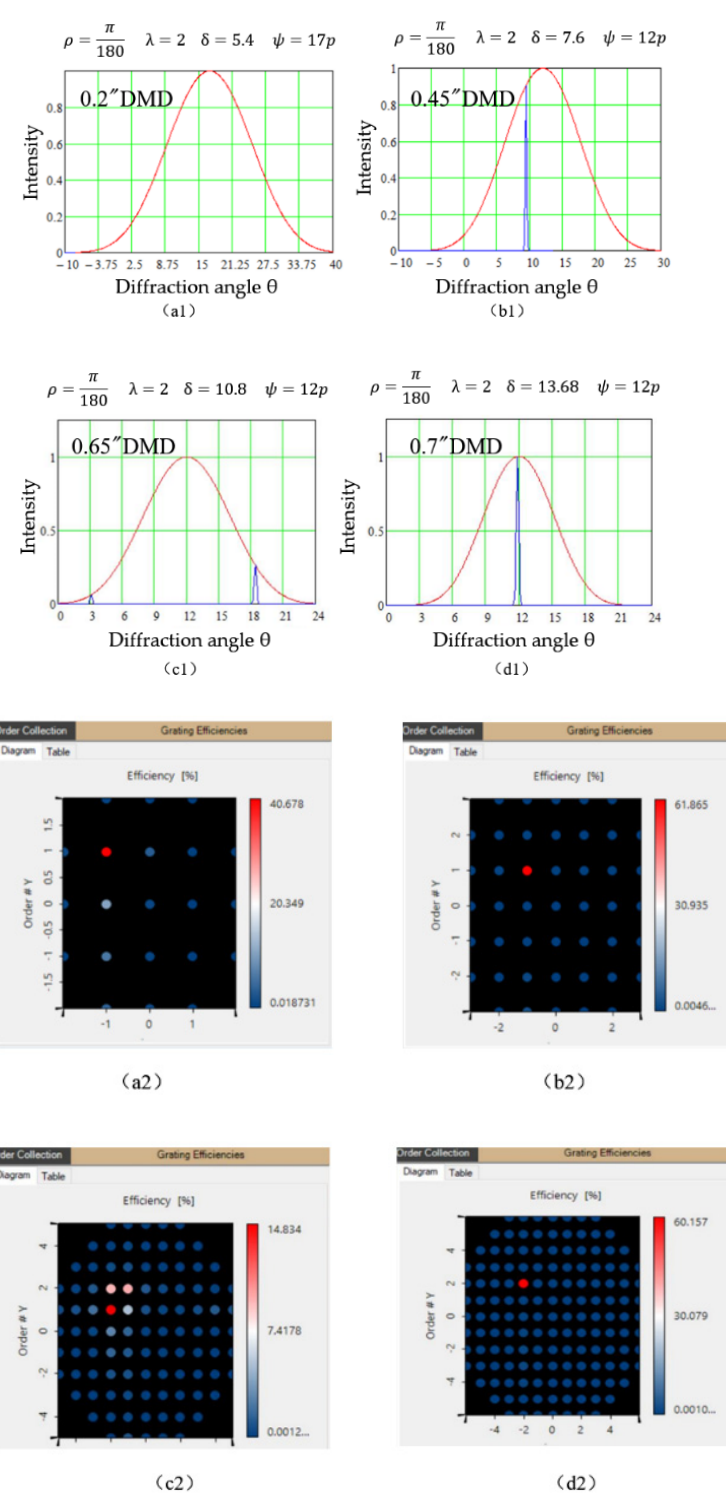
Figure 2. Diffraction distribution of 2 μ m-wavelength light radiating on 0.2”, 0.45”, 0.65” and 0.7” Figure 2. Di ff raction distribution of 2 µ m-wavelength light radiating on 0.2”, 0.45”, 0.65” and 0.7” DMDs DMDs at an incident angle 17° in ( a1 , a2 ) and 12° in ( b1 – d1 , b2 – d2 ), respectively. ( a1 – d1 ) are at an incident angle 17 ◦ in ( a1 , a2 ) and 12 ◦ in ( b1 – d1 , b2 – d2 ), respectively. ( a1 – d1 ) are theoretical results theoretical results on the bisecting plane (Red curves represent the single-pixel diffraction envelop on the bisecting plane (Red curves represent the single-pixel di ff raction envelop and the blue curves are multi-pixel interference.). ( a2 – d2 ) are corresponding di ff raction patterns in space by